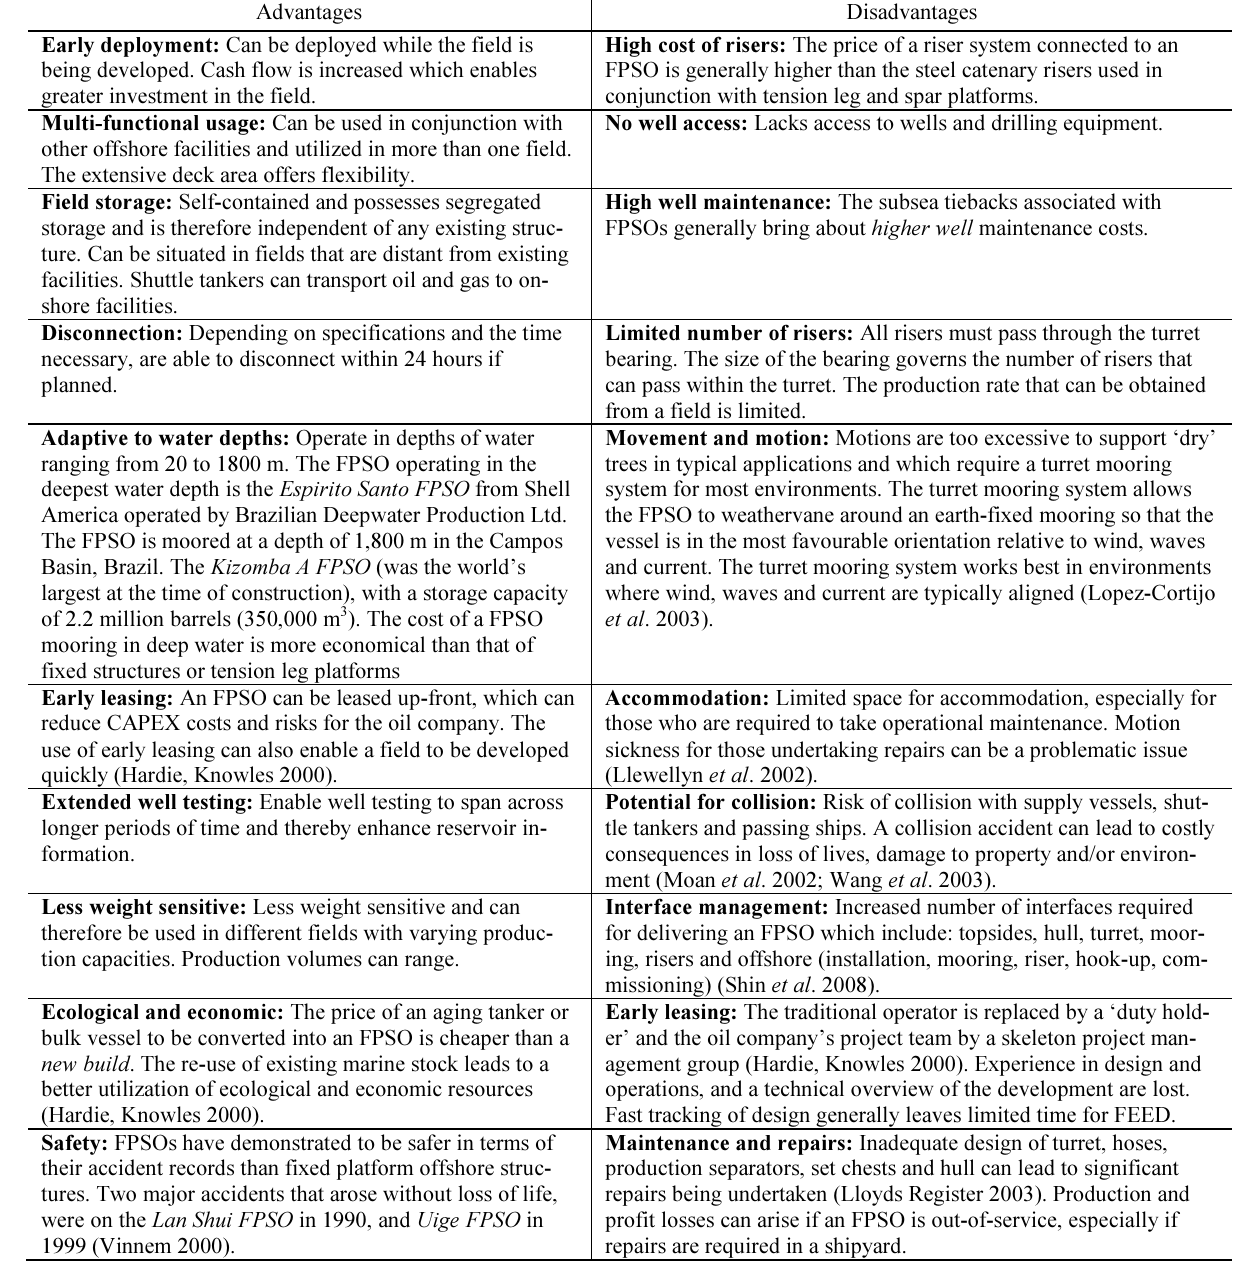
Table 1. Advantaged and disadvantages of